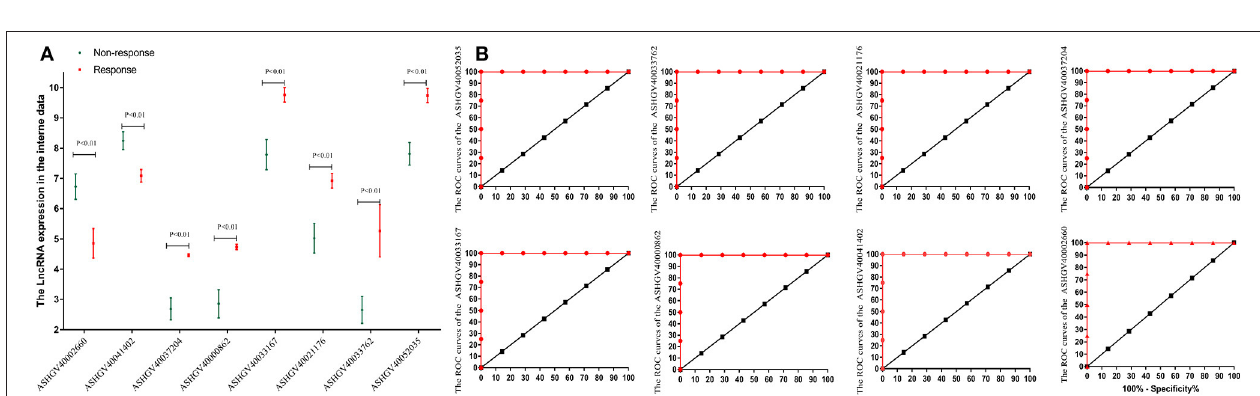
FIGURE 4 | Internal validation of hub lncRNAs. (A) In our data the hub long non-coding RNAs (lncRNAs) expression (all P < 0.01). (B) Receiver operating characteristic (ROC) analysis to evaluate the predictive efficiency of the hub lncRNAs using our data